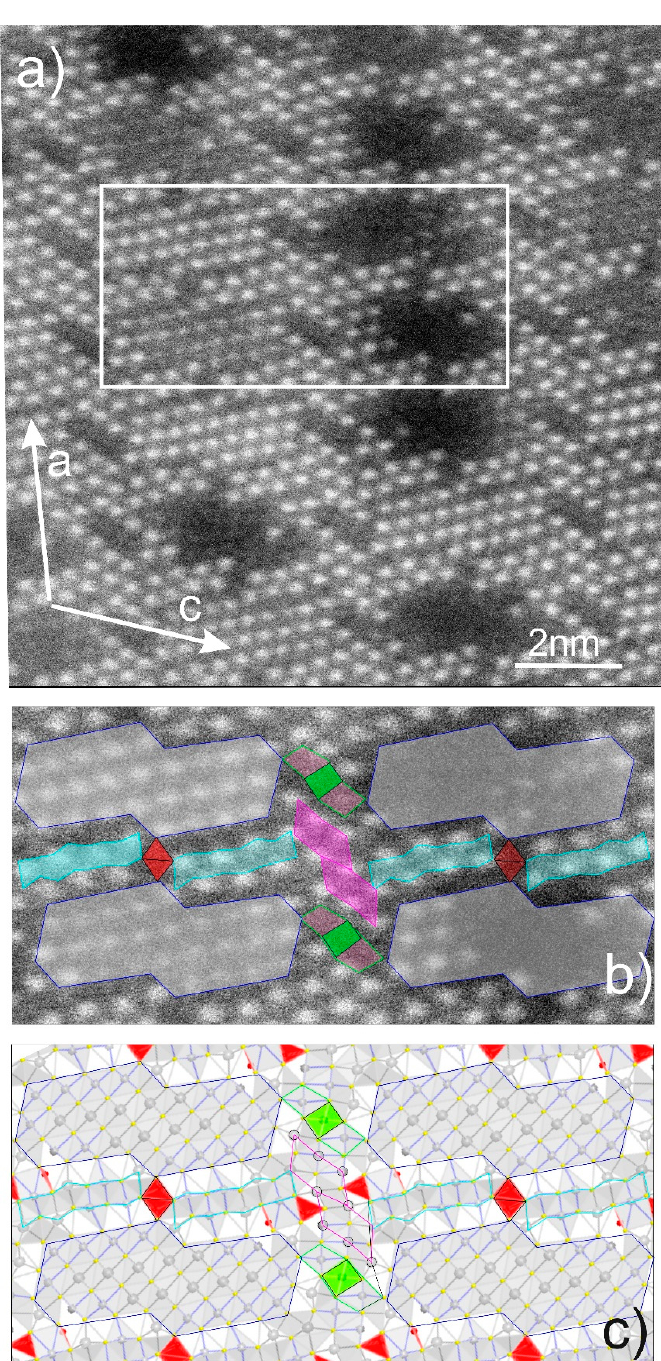
Figure 12. Crystal structural slabs in the dark Pb-Bi-sulphosalt (D), identified from the HAADF STEM image in ( a ) and, in ( b ); an enlargement of the white rectangle area in ( a ); matching the neyite structure [75]; ( c ) down to the [010] zone axis. The slabs are outlined by: (111) PbS —dark blue and grey shading; (100) PbS —light blue and grey shading. Note the excellent correlation between the number of heavy atoms (Pb, Bi as white dots on the HAADF STEM images and small and larger grey balls on the sketch in ( c )). The small rhombs in red correspond to Cu whereas the green rectangles show Ag positions. The purple shading in ( b ), and outlines in ( c ), show two small sheared blocks alternating with the Ag-bearing slabs (green outline on ( c )). Note that these are dark on the HAADF STEM images ( a , b ), suggesting that they host atoms lighter than Bi and Pb considered in the structural model. See the text for additional explanation.